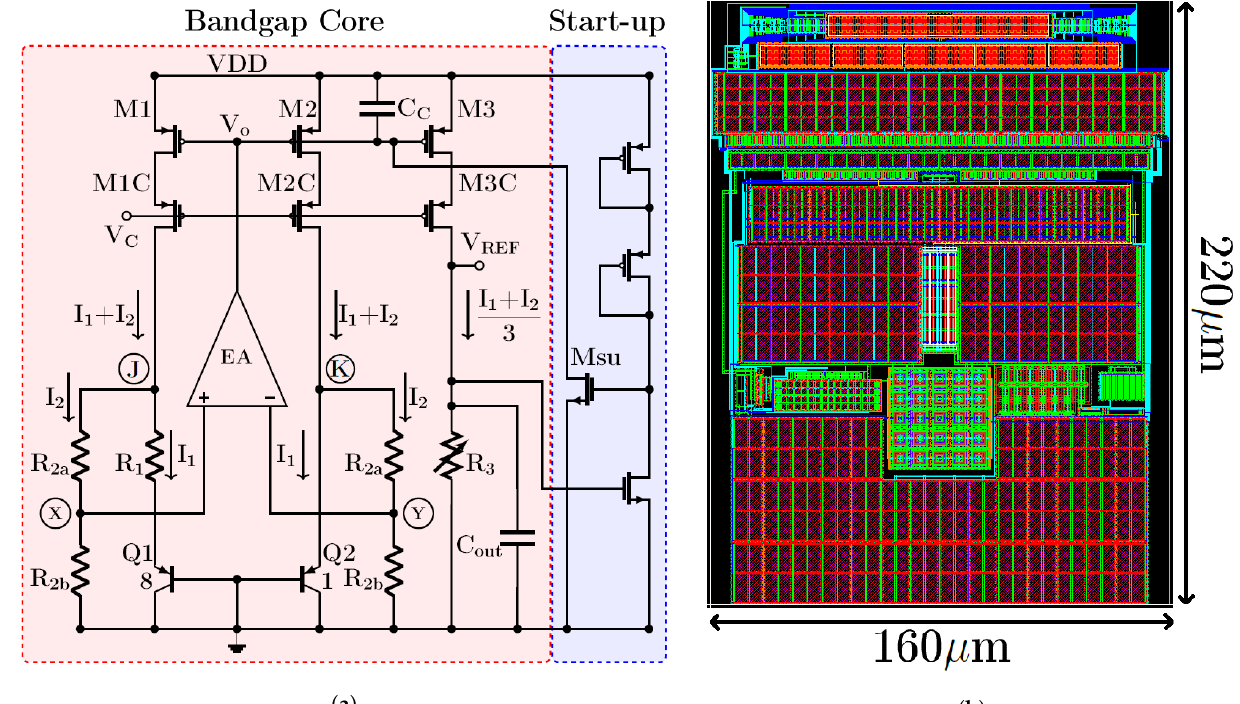
Figure 6. The 65 nm bandgap structure ( a ) schematic and ( b ) layout (total area = 0.0352 mm 2